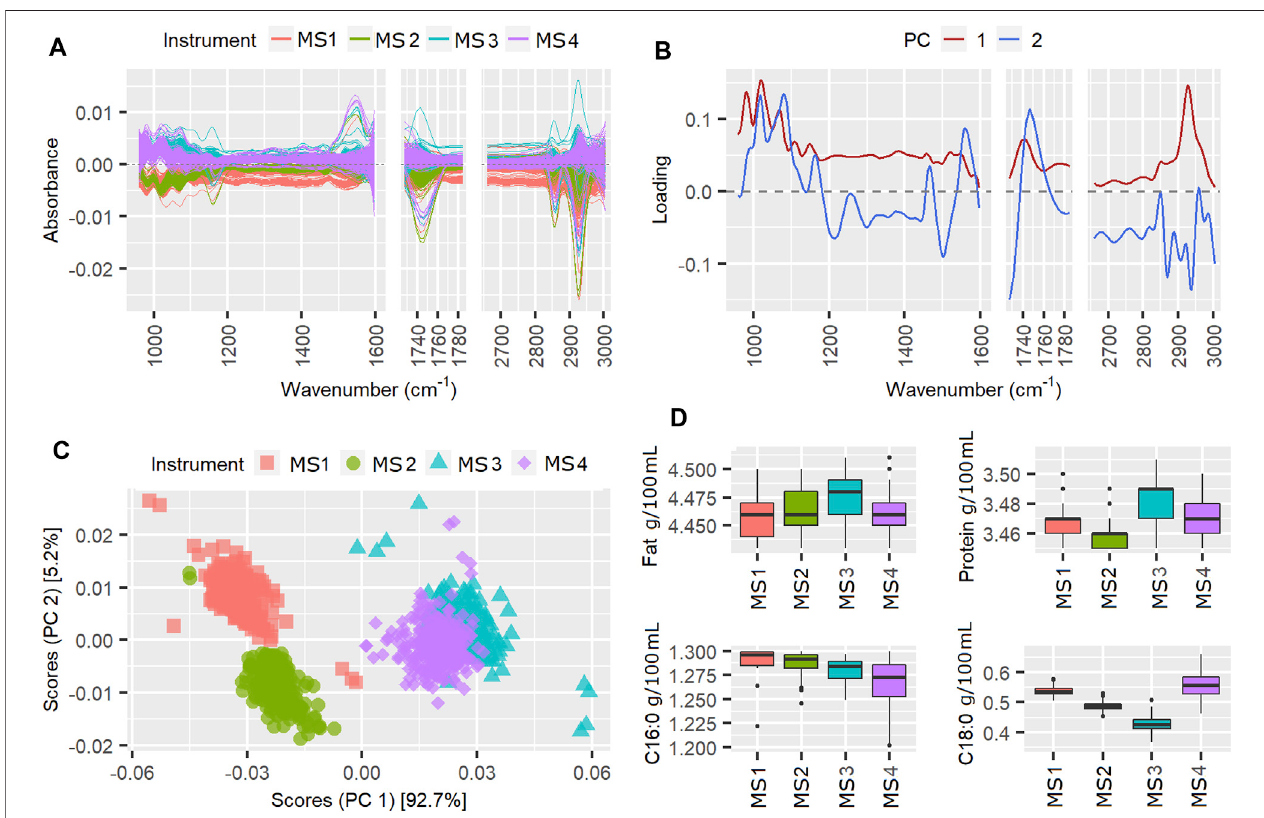
FIGURE 3 | Mean centered spectra (A) , instrument loading plots (B) and scores (C) for pilot spectra from week 50, in which the TSSQ (adj) exceeded 3 standard deviations. Boxplots (D) show the predicted fat, protein, C16:0 and C18:0 values from each instrument and their mean values and standard deviations (SDs), marked * for 1SD, ** for 2SDs and *** for 3SDs greater than the SD of the 177 weeks TSSQadj